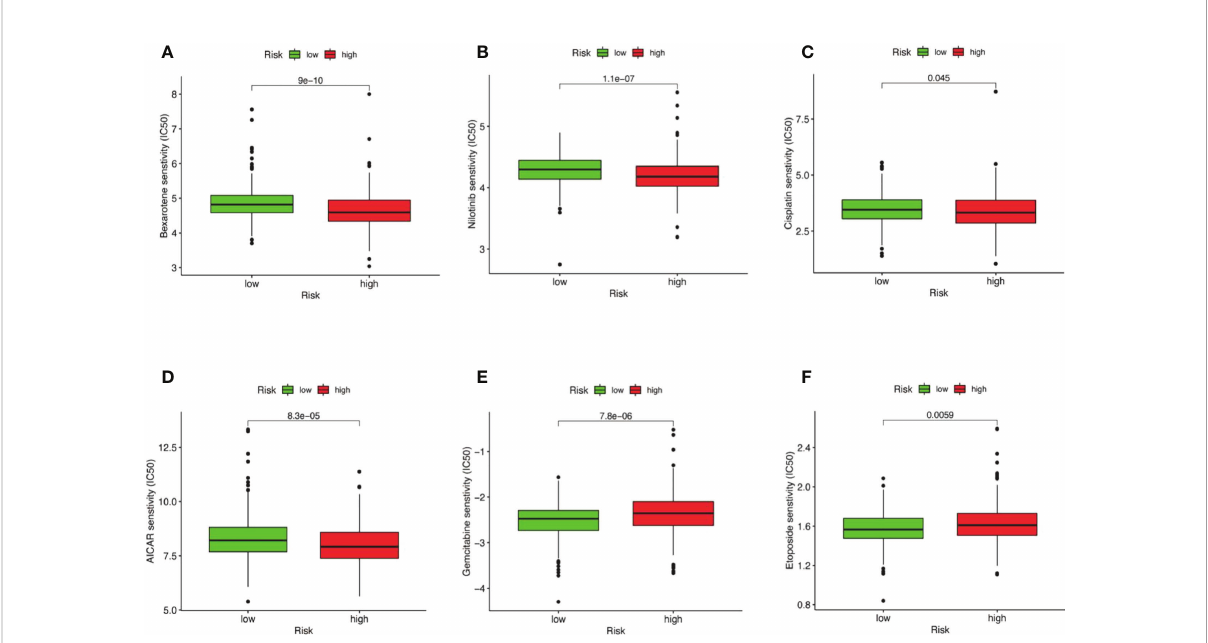
FIGURE 12 Correlation between risk score and drug resistance. The box plot displays the relationship between the risk score and the IC50 of various drugs. (A) IC50 of bexarotene in high and low risk groups. (B) IC50 of nilotinib in high and low risk groups nilotinib. (C) IC50 of cisplatin in high and low risk groups. (D) IC50 of AICAR in high and low risk groups. (E) IC50 of Gemcitabine in high and low risk groups. (F) IC50 of etoposide in high and low risk